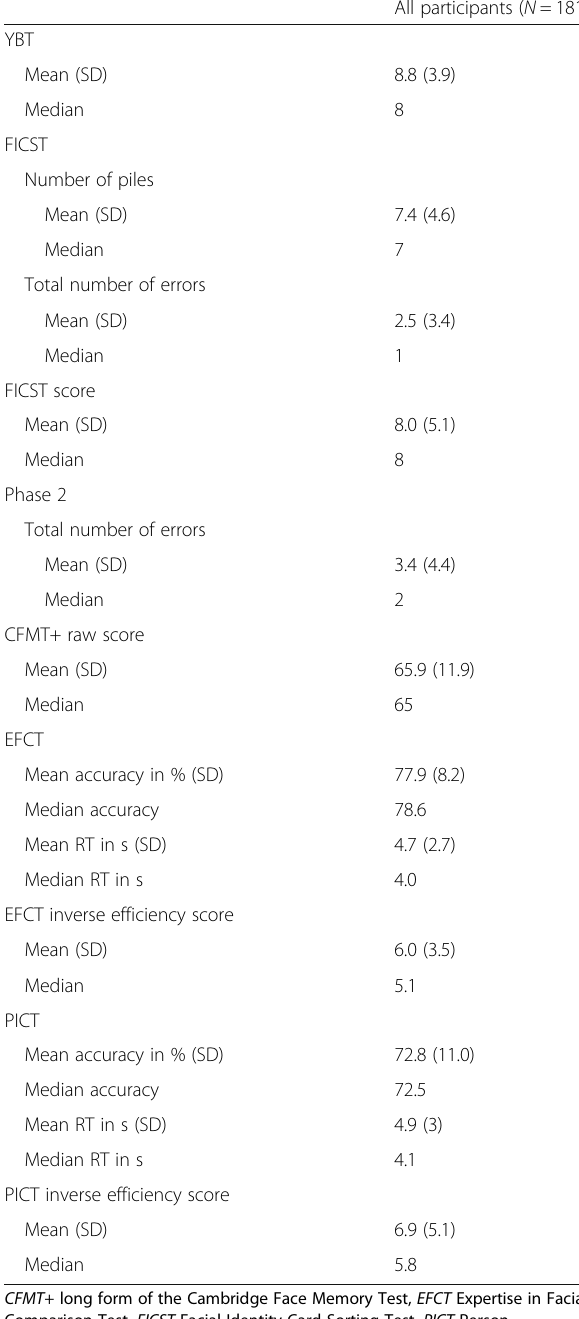
Table 4 Normative data for participants who completed the YBT, FICST, CFMT+, EFCT and PICT